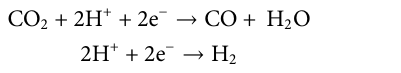
Frontiers in Energy Research |